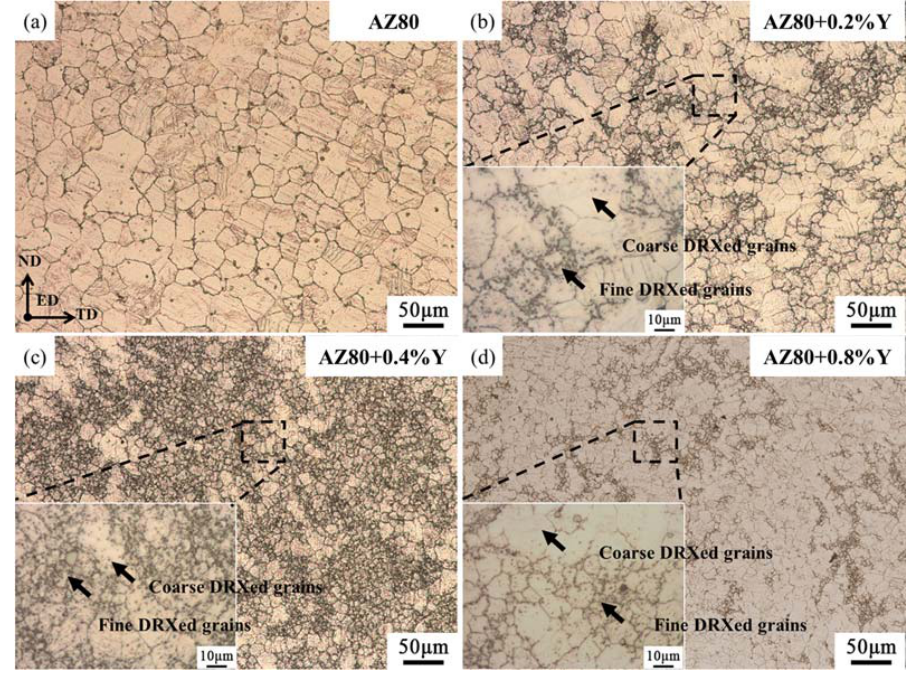
Figure 1. Microstructure of the extruded alloys: ( a ) AZ80; ( b ) AZ80M1; ( c ) AZ80M2; and ( d ) AZ80M3.